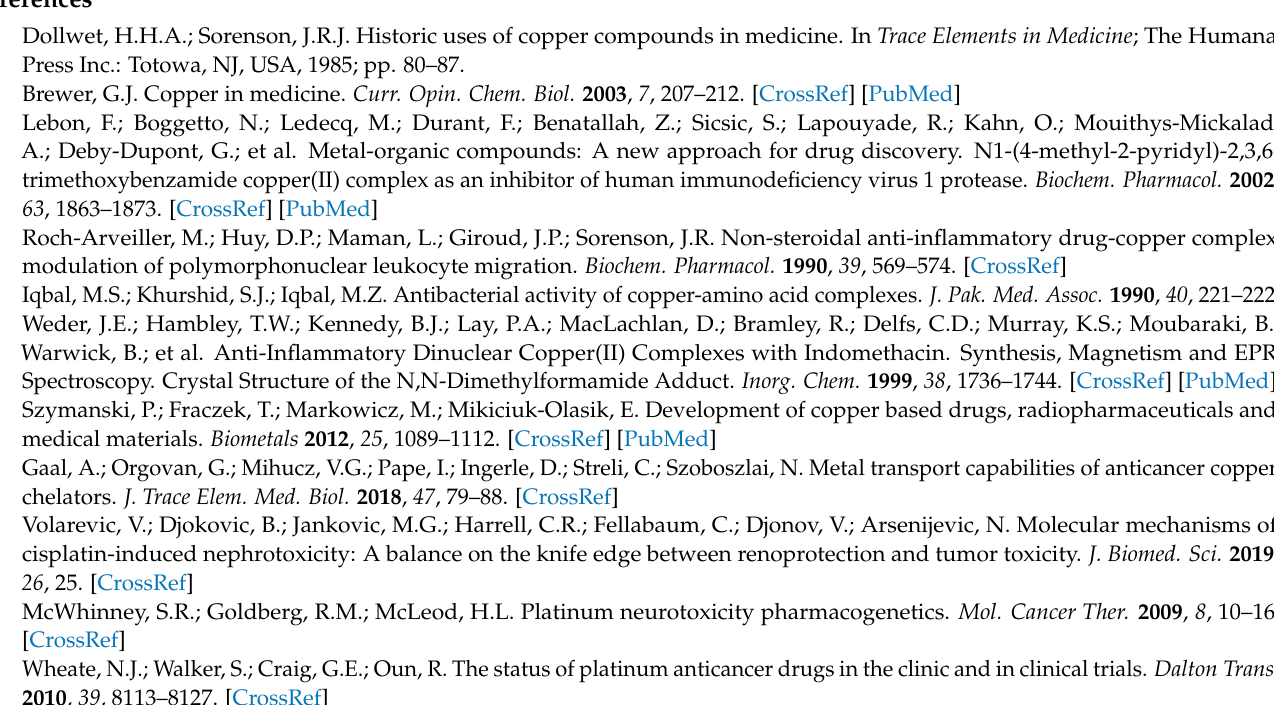
Figure S6: Representative histograms showing cell cycle arrest following treatment with DMSO, Cu-1 and L1 in MCF-7 cells, Figure S7: Representative dot plots from flow cytometric analysis of the annexin V–FITC/PI assay in MCF-7 cells after treatment with either DMSO or the IC 50 concentration of Cu-1 and L1 for 72 h. Table S1: Hydrogen bonds in complex Cu-1 . CCDC 2233056 ( Cu-1 )